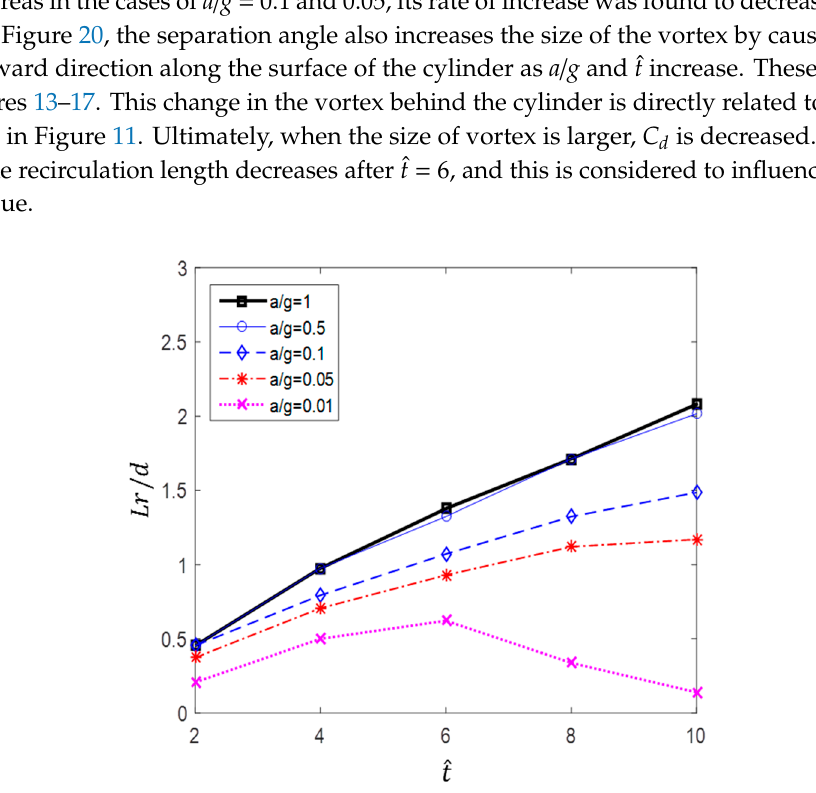
Figure 18. Definition of recirculation length and separation angle